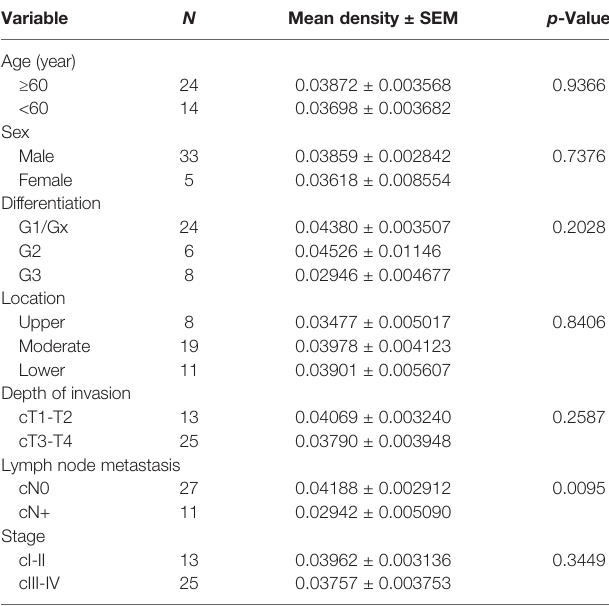
TABLE 2 | Association of MMS22L expression in the biopsy specimens with clinicopathological parameters. Variable